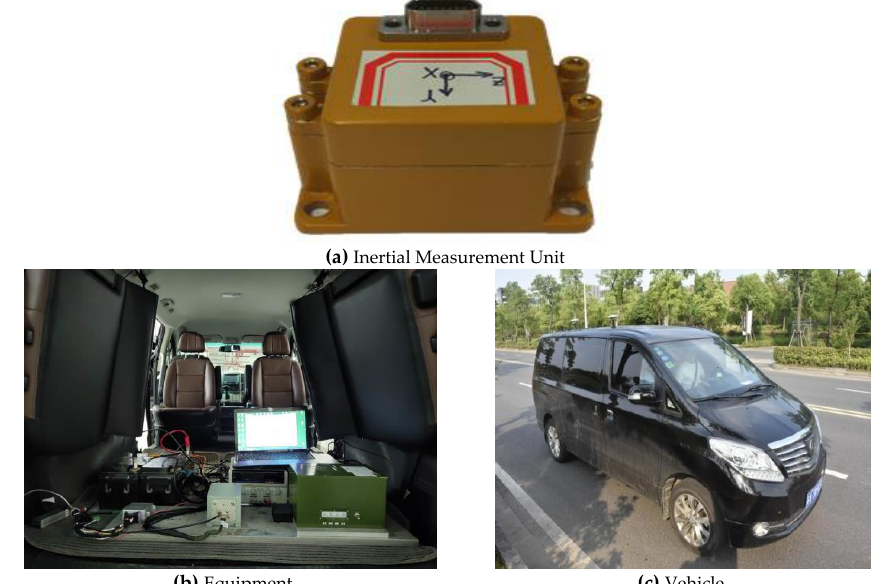
Table 1. Inertial Measurement Unit (IMU) specifications.